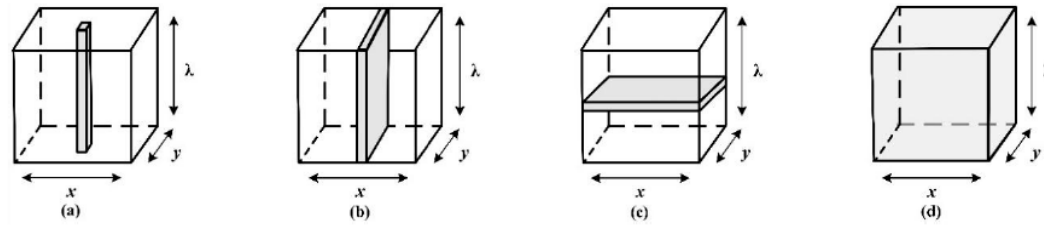
Figure 2. The basic hyperspectral imaging scanning modes: ( a ) point scanning, ( b ) line scanning, ( c ) area scanning, ( d ) single shot. x and y represent the spatial coordinates, λ represents the wavelength [3].